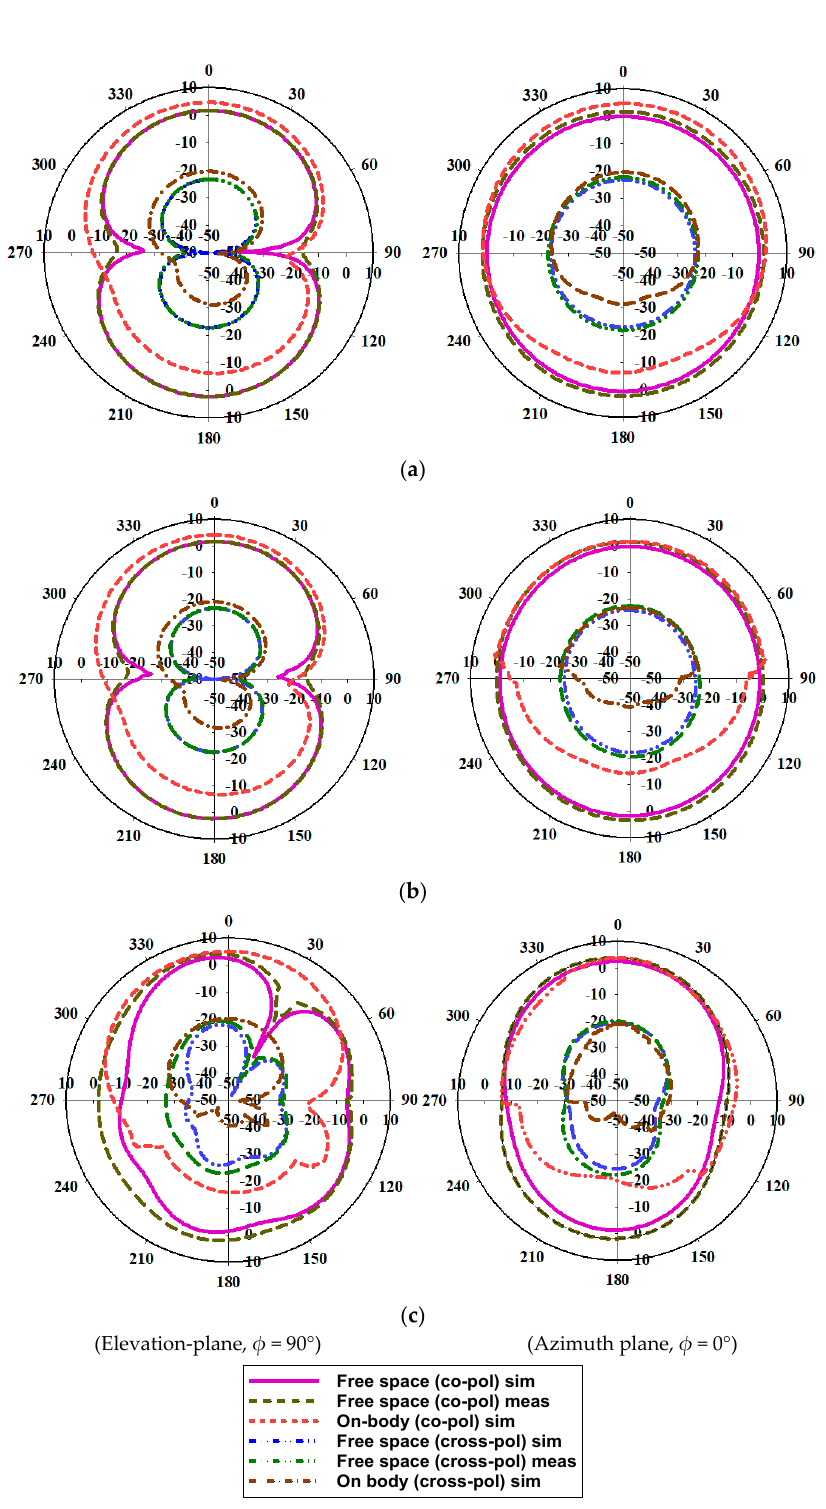
Figure 13. Radiation patterns of the antenna (gain in dBi and angle in degree). ( a ) 4 GHz; ( b ) 7 GHz; ( c ) 10 GHz.